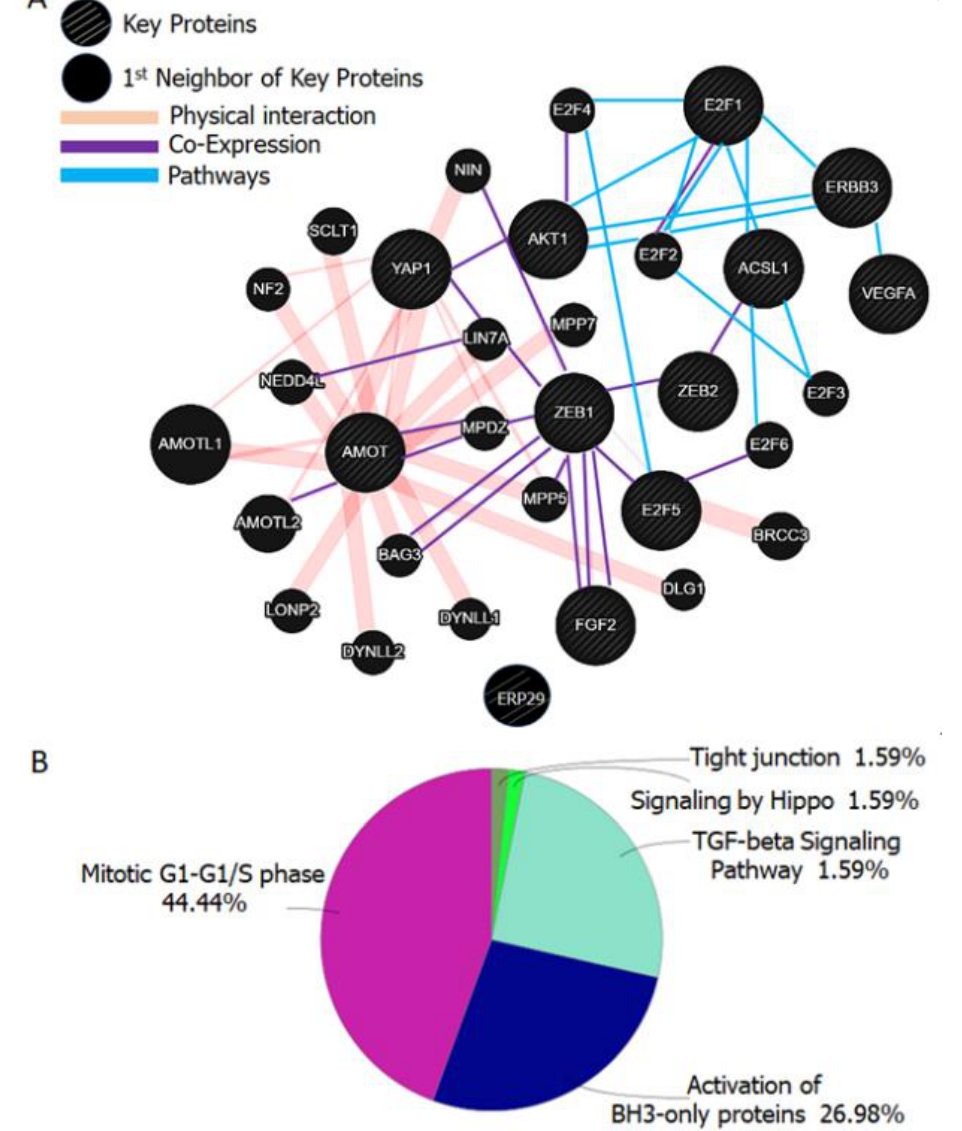
Figure 3. ( A ) Protein Interaction Network: Network generated by Cytoscape and GeneMANIA was used for the analysis of interaction network. Parameters that were used for networking: Max resultant genes were 20 and max resultant attributes were 10 and the weighing method was automatically selected from weighting methods. ( B ) Pathway enrichment analysis of key and neighboring proteins. Pathway enrichment analysis and Pie chart of 12 key and 20 neighboring proteins were generated by using ClueGO, a plug-in of Cytoscape (pV ≤ 0.05, with two-sided hypergeometric test and the pV correction is Bonferroni step down).